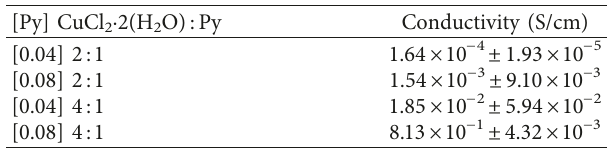
1: Electrical conductivity of BNC/PPy · CuCl 2